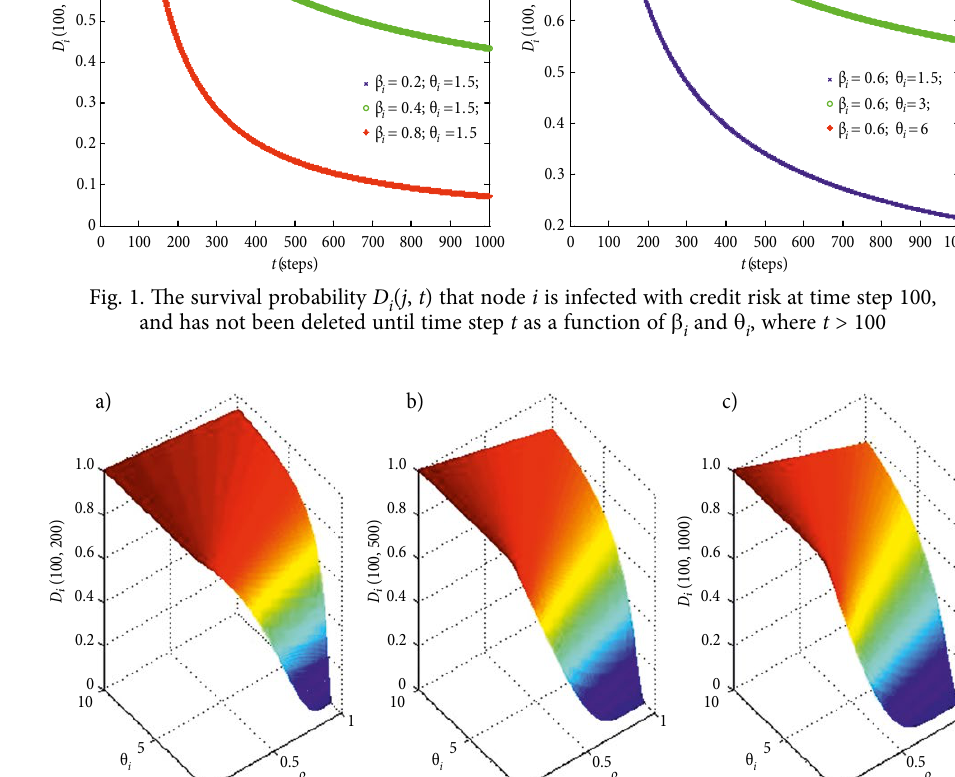
( j , t ) of node i under the interaction effects of b i